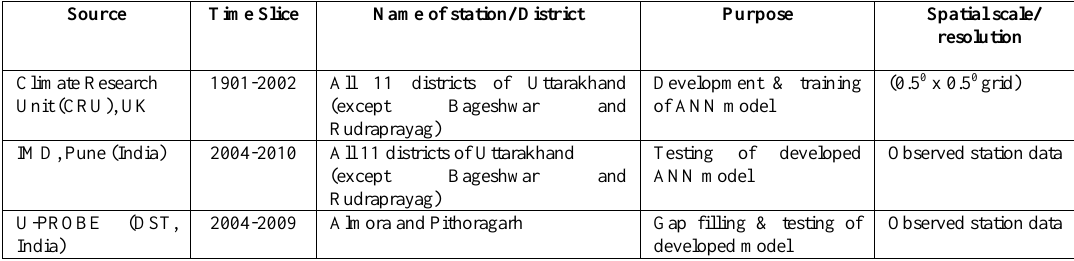
Table 1. Dataset used in the present